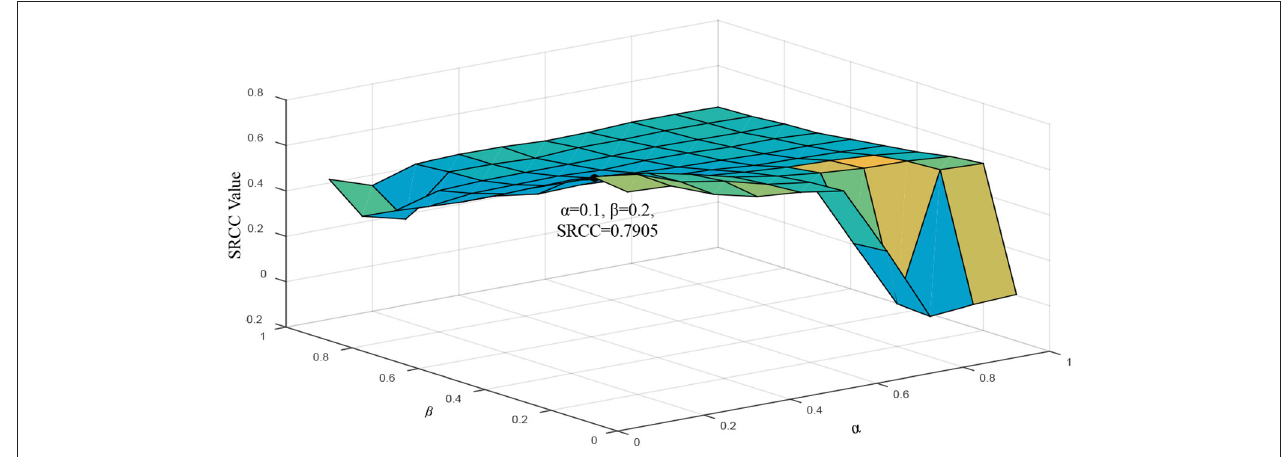
FIGURE 5 | The impact of the parameters α and β on the robustness of the proposed TDI metric.